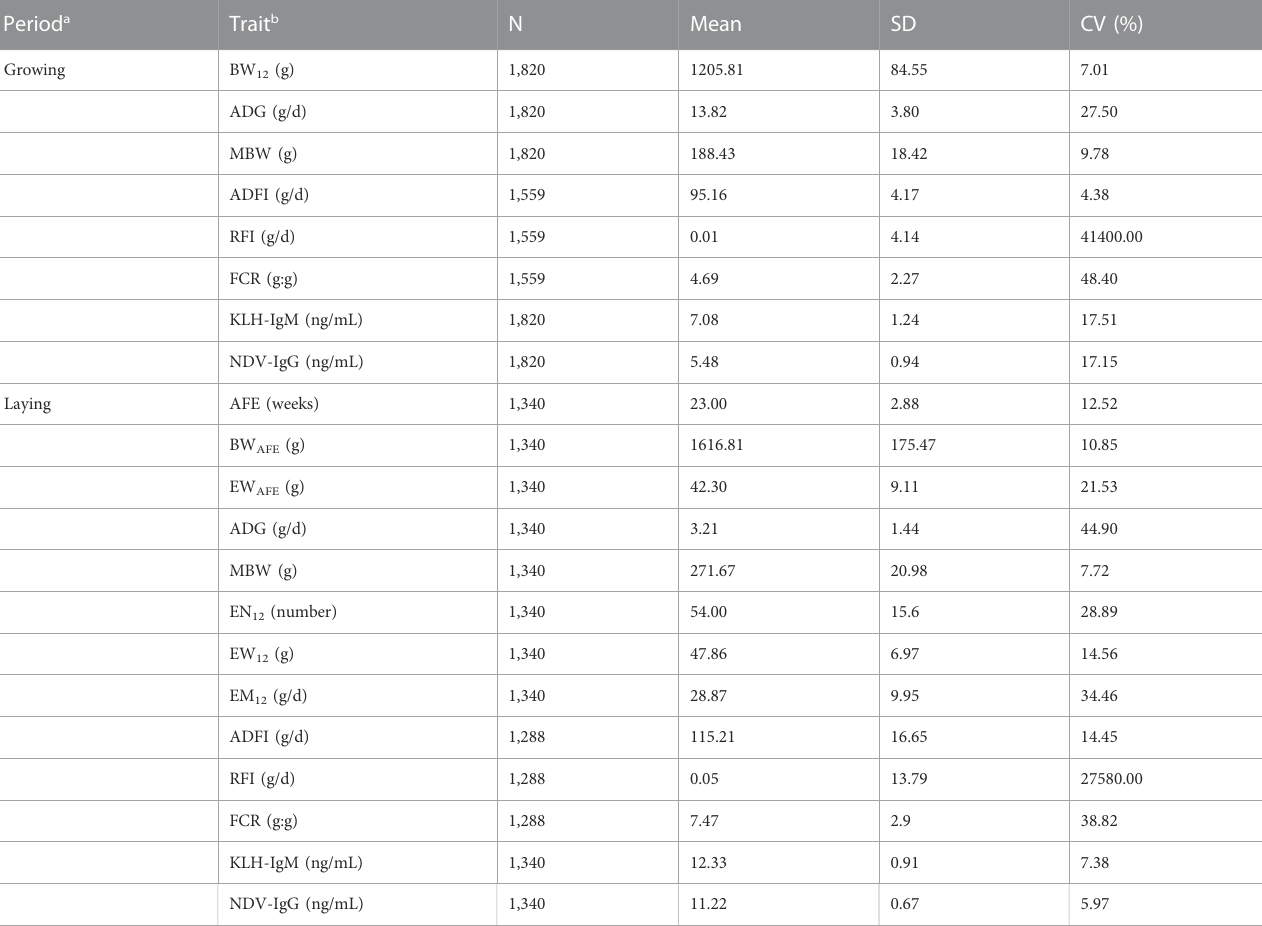
TABLE1Numberofobservations(N),mean,standarddeviation(SD)andcoef fi cientofvariation(CV)ofproduction,feedef fi ciencyandimmunetraitsmeasuredduring the growing and laying